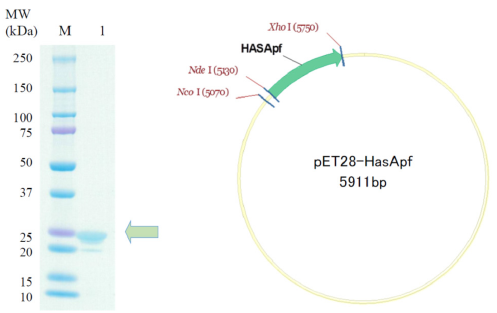
Figure 1. SDS-PAGE of a HasApf gene product (10 µ L) from a cloned vector (pET28a-HASApf) which was transformed into BL21(DE3) E. coli cells: M = Precision Plus Protein Dual Color Standards, 1 = HasApf sample after purification. Phoresis buffer: 25 mM Tris pH 8.3, 192 mM glycine, 0.1% SDS.